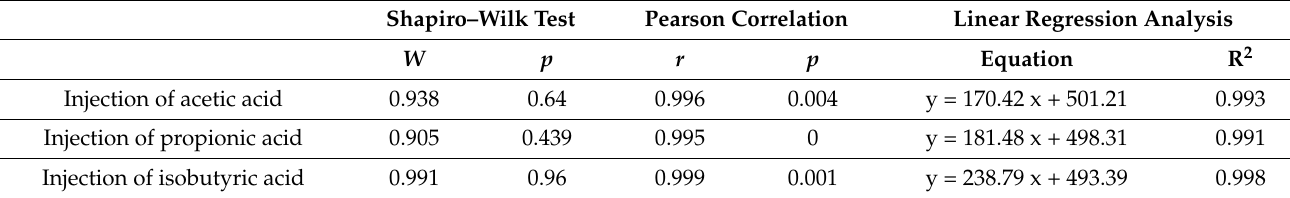
Figure 5. Cumulative biogas production (CBP) using gelatin as substrate in bioreactors with added acetic acid, pro-pionic acid, and isobutyric acid. Table 4. Statistical